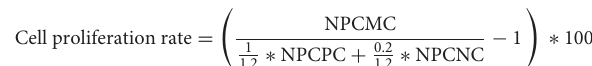
( Supplementary Table 1 ) and WT pig were excised and